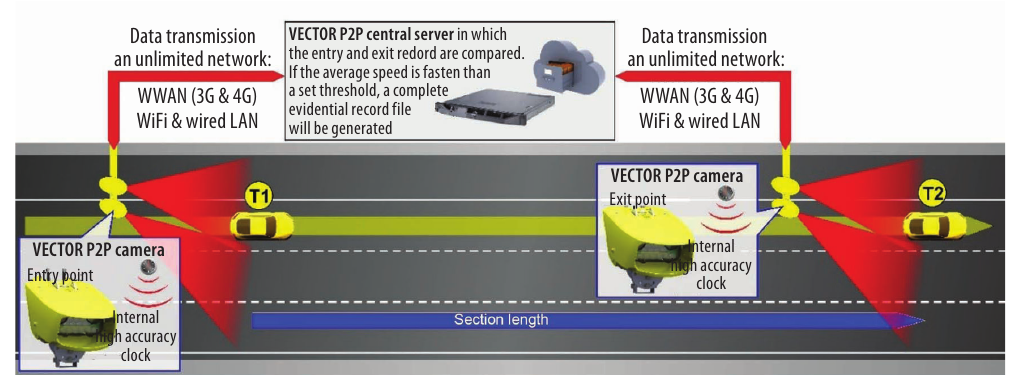
Figure 1. A principle scheme of TraffiSection VECTOR P2P operation